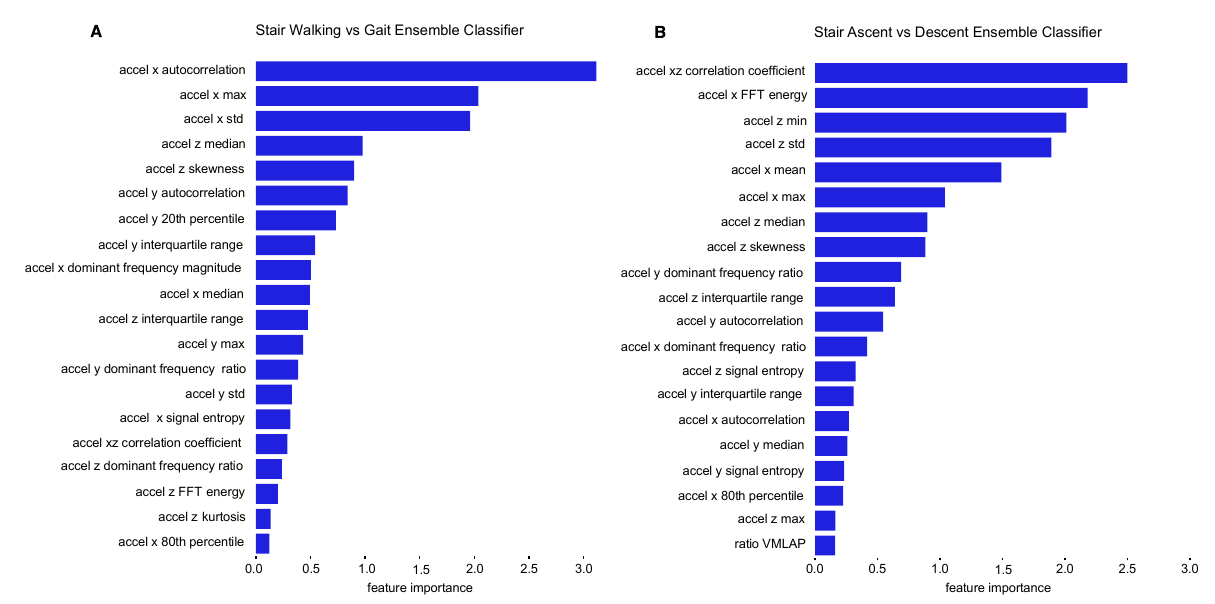
Figure 7. ( A ) Feature importances for accelerometer feature based ensemble stair walking vs. gait classifier. Accelerometer x autocorrelation, accelerometer x maximum, accelerometer x standard deviation, accelerometer z median, accelerometer z skewness, accelerometer y autocorrelation, and accelerometer y 20th percentile were the most predominant features ( B ) Feature importances for ensemble stair ascending vs. descending classifier. Accelerometer xz correlation coefficient, accelerometer x FFT energy, accelerometer z minimum, accelerometer z standard deviation, accelerometer x mean, accelerometer x maximum, and accelerometer z median were the most predominant features.